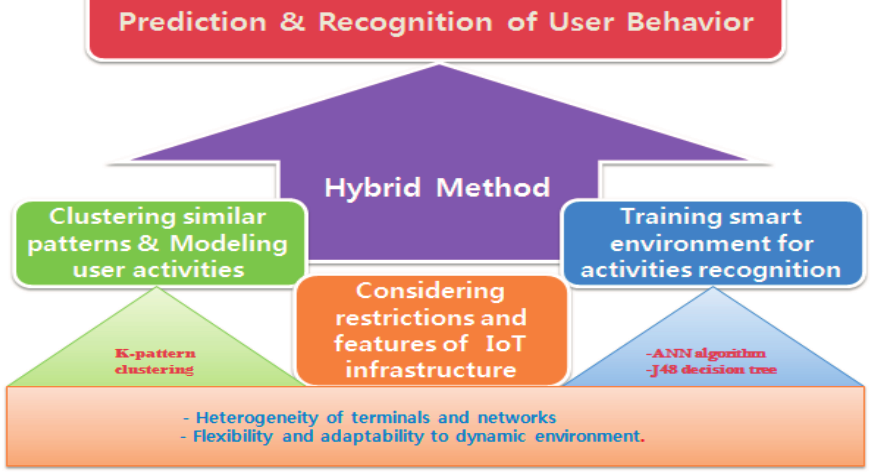
Figure 2. Architecture of hybrid